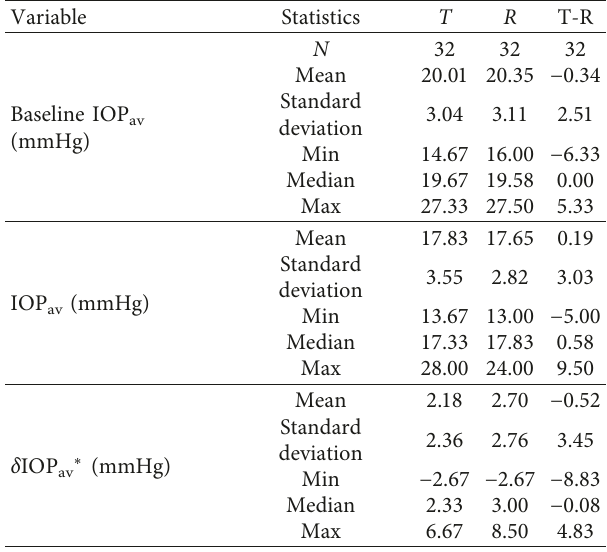
Table 4: Summary statistics for the average IOP in the study eye.